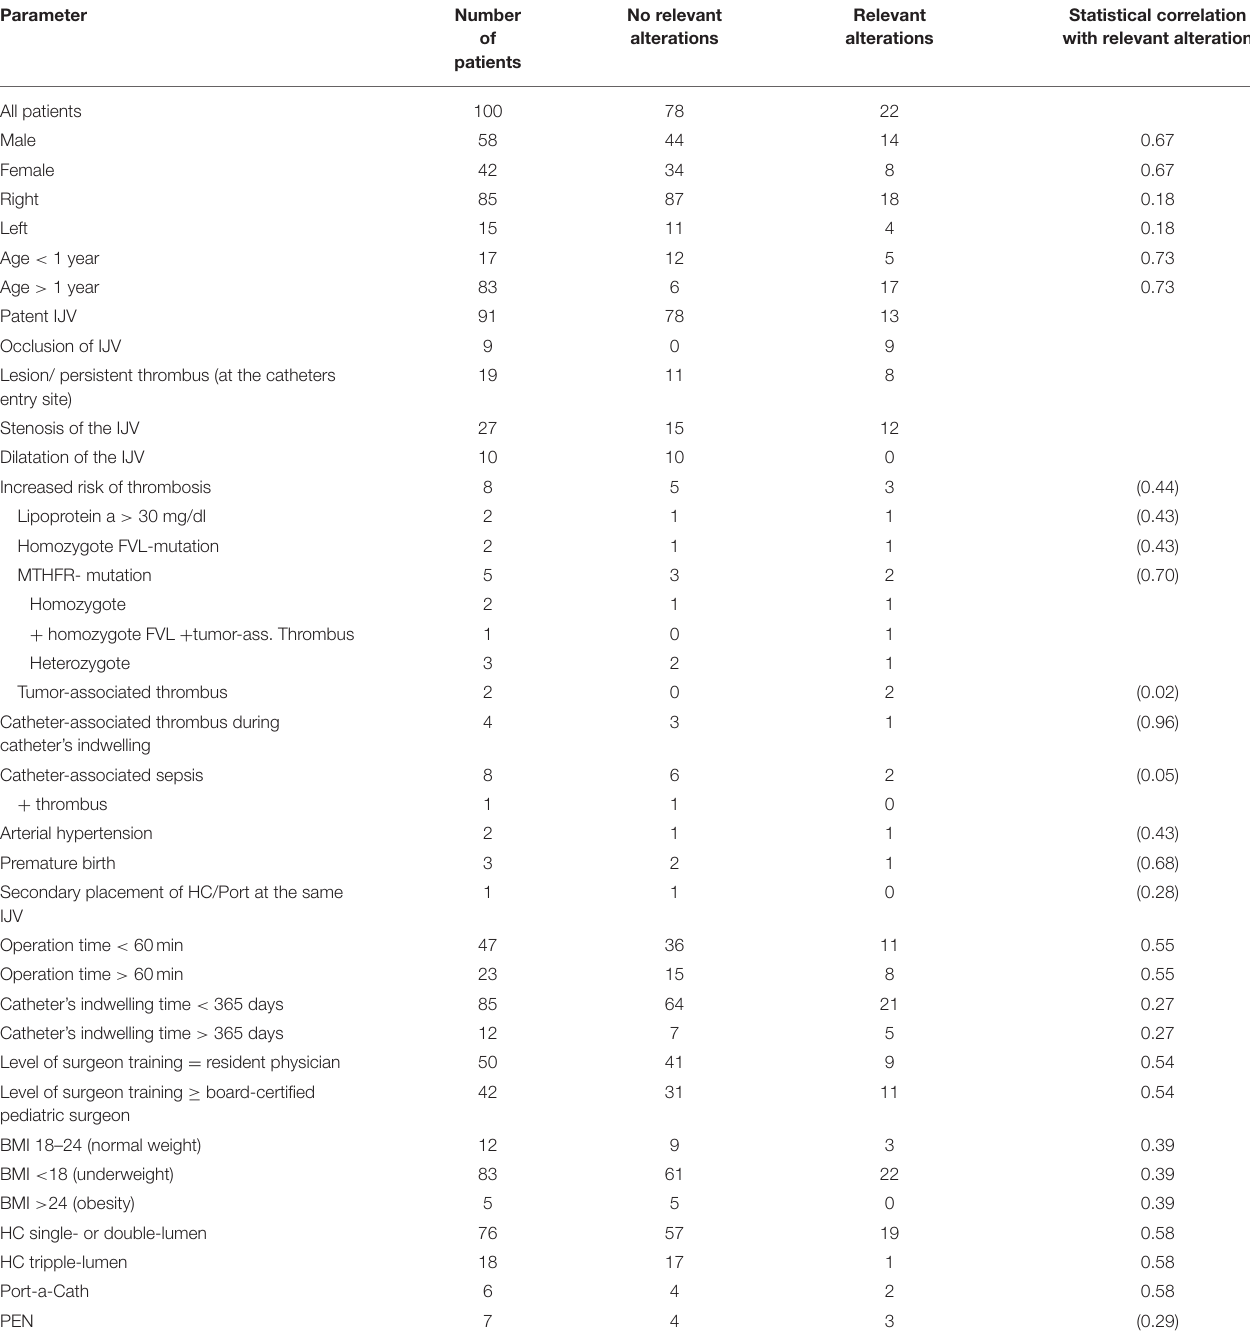
TABLE 3 | Patient data and Doppler sonographic